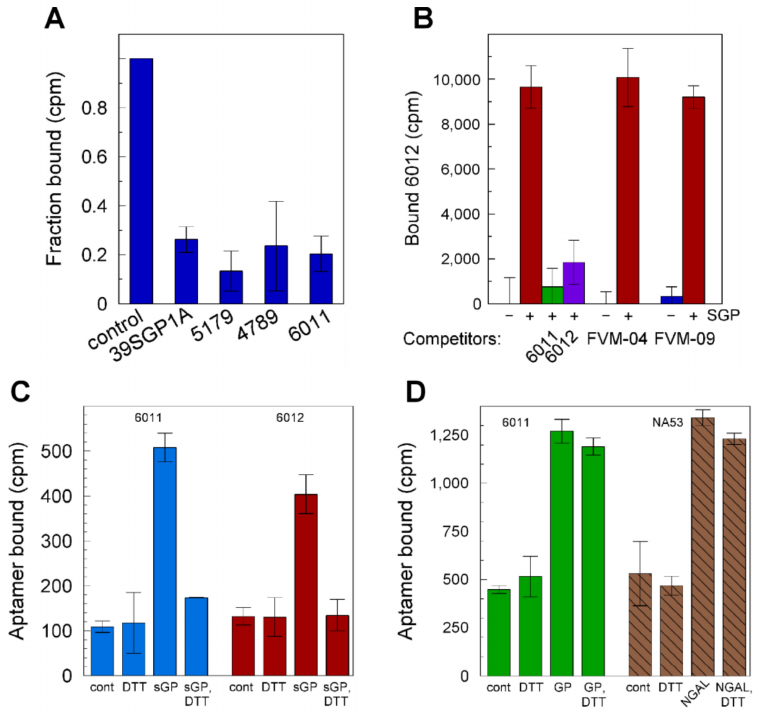
Figure 4. Analysis of aptamer and antibody binding to EBOV sGP . ( A ) Binding of 200 nM 32 P- 39SGP1A to 4 µ M EBOV sGP in the presence of the listed oligonucleotides, each at 13.3 µ M. ( B ) Bind- ing of 10 nM 32 P-6012 to EBOV sGP in the presence or absence of 6011 or 6012 (each at 102 nM) or in the presence or absence of antibody, FVM-04 or FVM-09 (each at 1 µ M). ( C ) Binding of 10 nM 32 P-6011 (blue) or 32 P-6012 (red) (each at 10 nM) to 1 µ M EBOV sGP in the presence or absence of 10 mM DTT. ( D ) The effect of 10 mM DTT on the binding of 10 nM 32 P-6011 to 0.5 µ M EBOV GP1,2 (green) or 32 P-NA53 to NGAL (hatched brown). Binding assays were performed in PBS (6011, 6012) or NBB (NA53) at 23 ◦ C. Standard deviations were calculated, as described in Materials and Methods, to include the error in the blank when that was